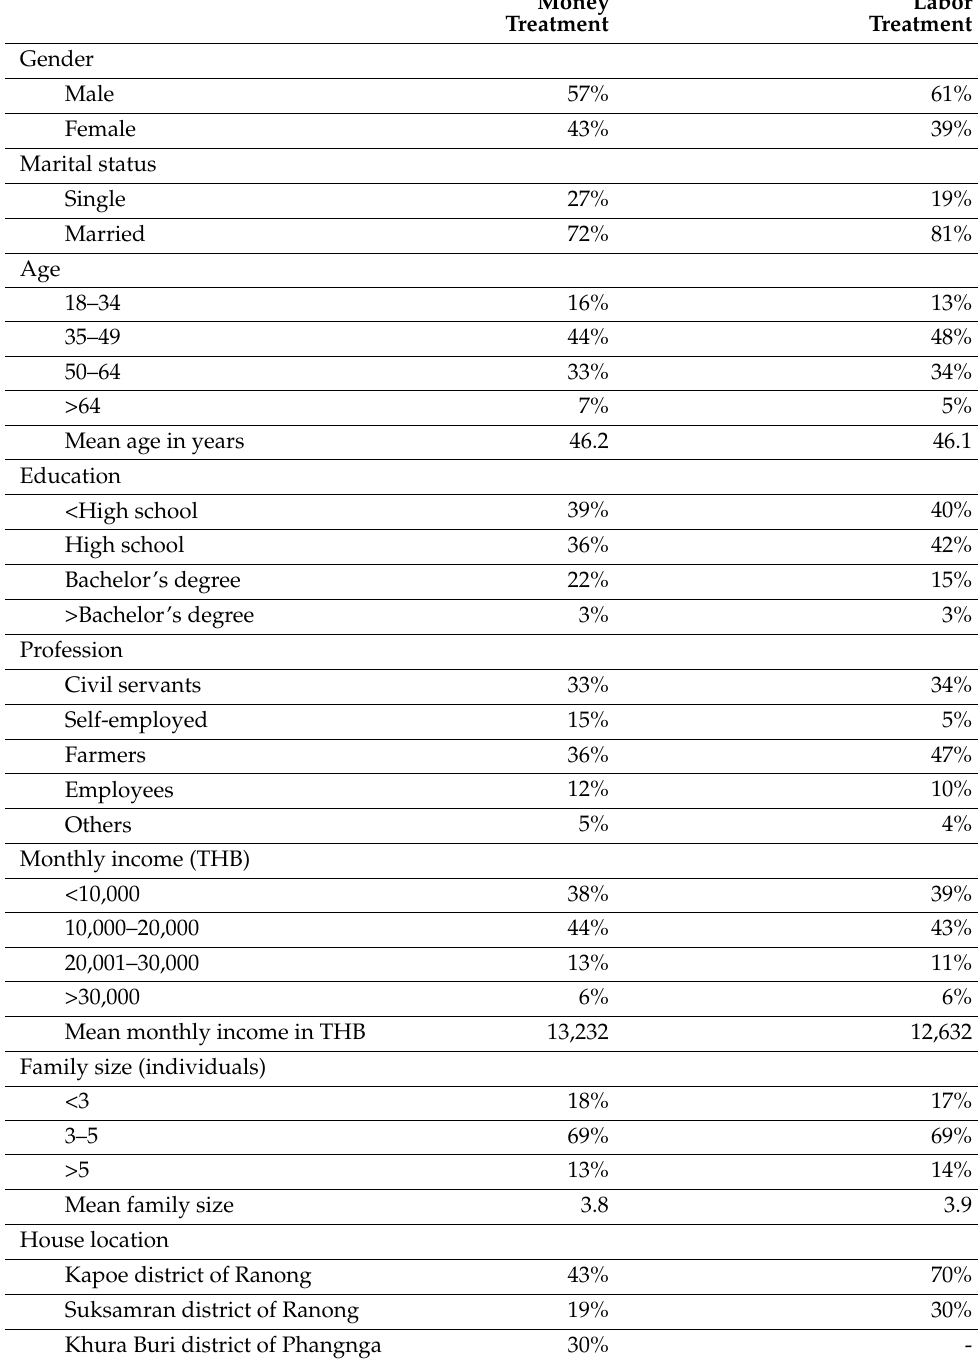
Table 4. Socioeconomic characteristics of the